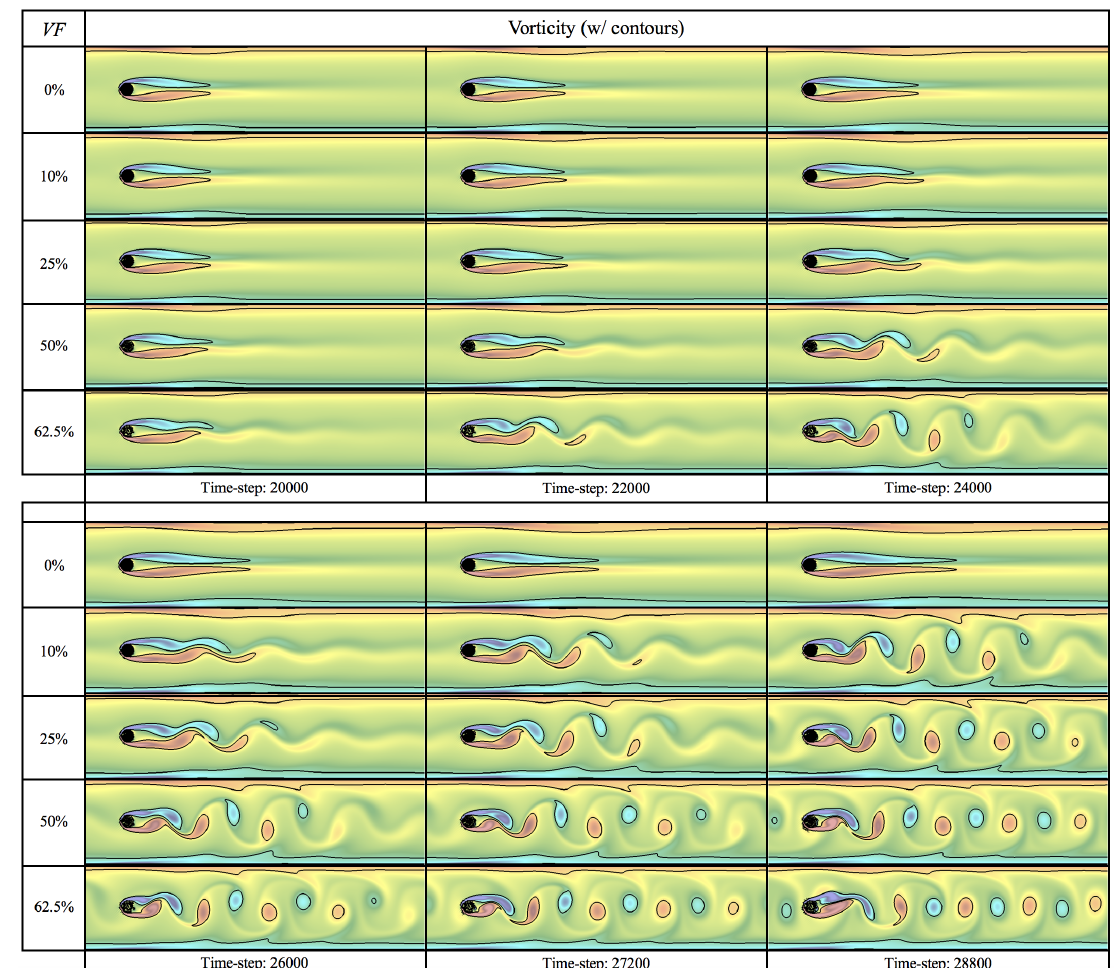
Figure 38. Snapshots illustrating vorticity (with its contours) among cases of differing void fractions, VF